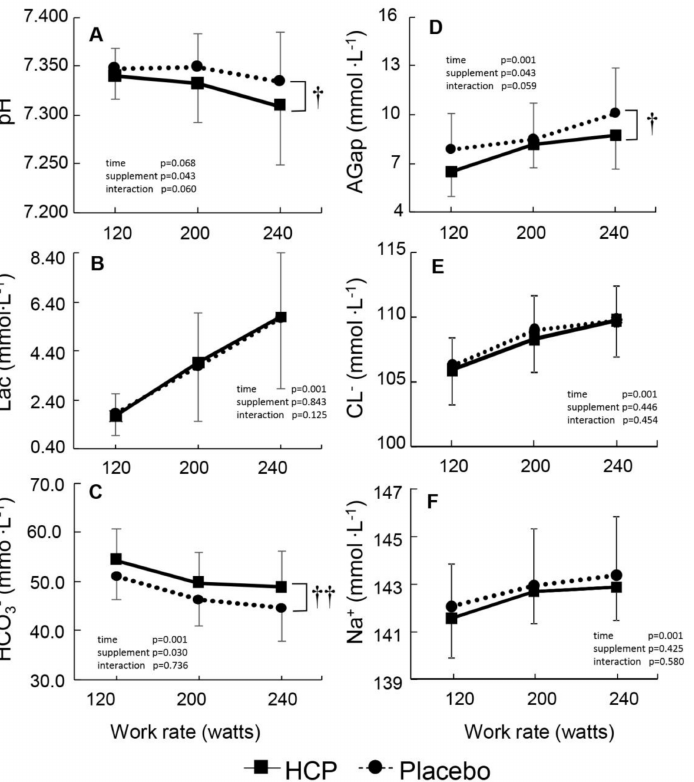
Figure 2. Group mean values of peripheral venous blood pH ( A ), lactate (Lac) ( B ), bicarbonate (HCO 3 − ) ( C ), aniongap (AGap) ( D ), chloride (Cl − ) ( E ), and sodium (Na + ) ( F ) with the function of different work rates during the cycle exercise in the HCP and placebo groups. Error bars: SD. Significant difference between HCP and placebo at higher work rates † p < 0.05, †† p <